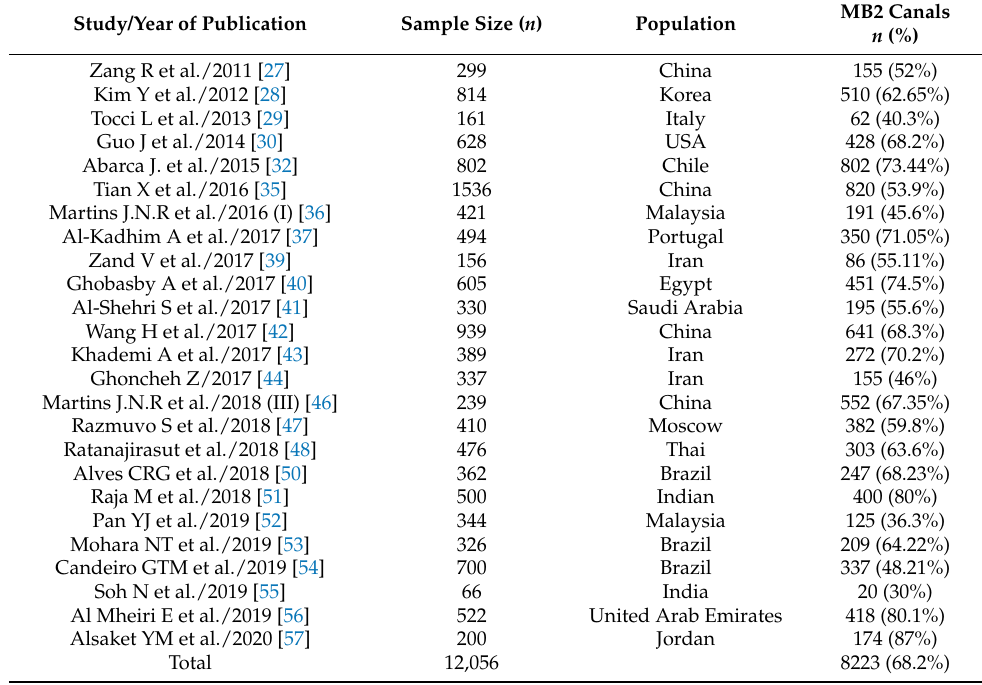
Table 2. Prevalence of MB2 canals in maxillary first